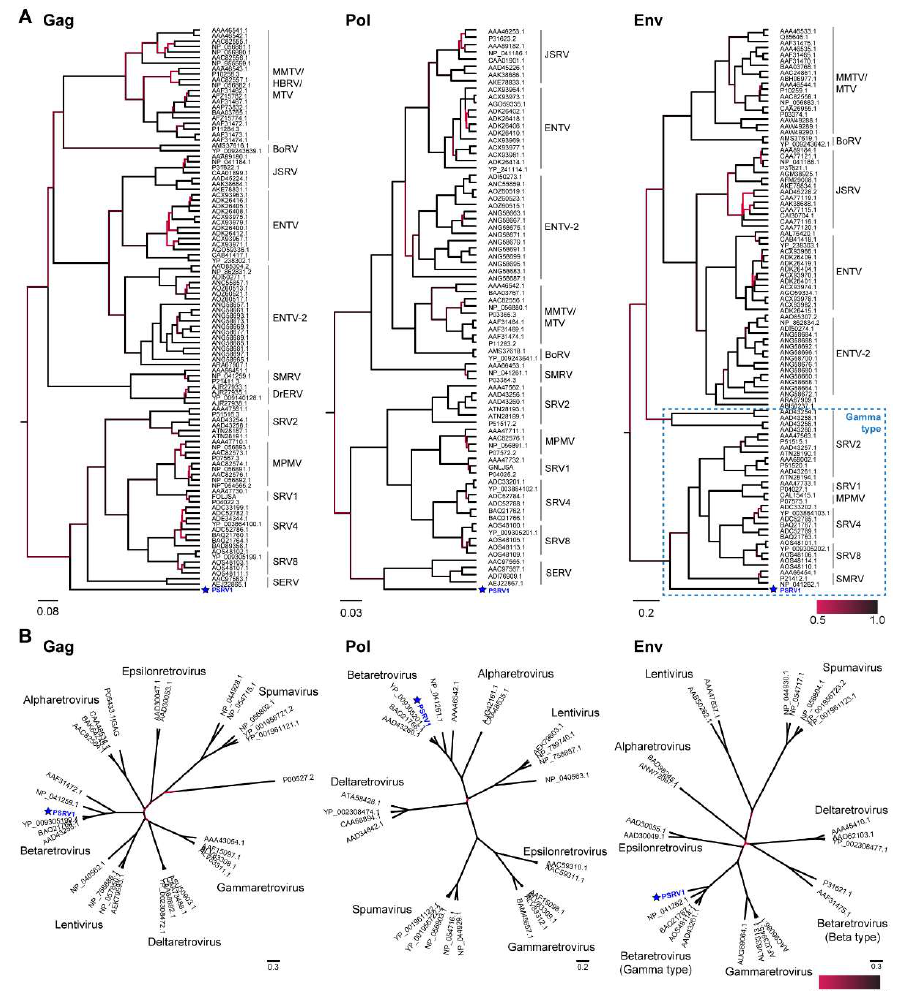
Figure 2. Phylogeny of PSRV1 and closely related retroviruses. ( A ) Phylogenies generated by Bayesian inference of Gag, Pol, and Env sequence alignments. ( B ) Phylogenies of Gag, Pol, and Env protein sequence alignments from PSRV1 and representative genome sequences of genera within the Retroviridae family are shown. Scale indicates posterior probability values. Viruses 2021 , 13 , x FOR PEER REVIEW